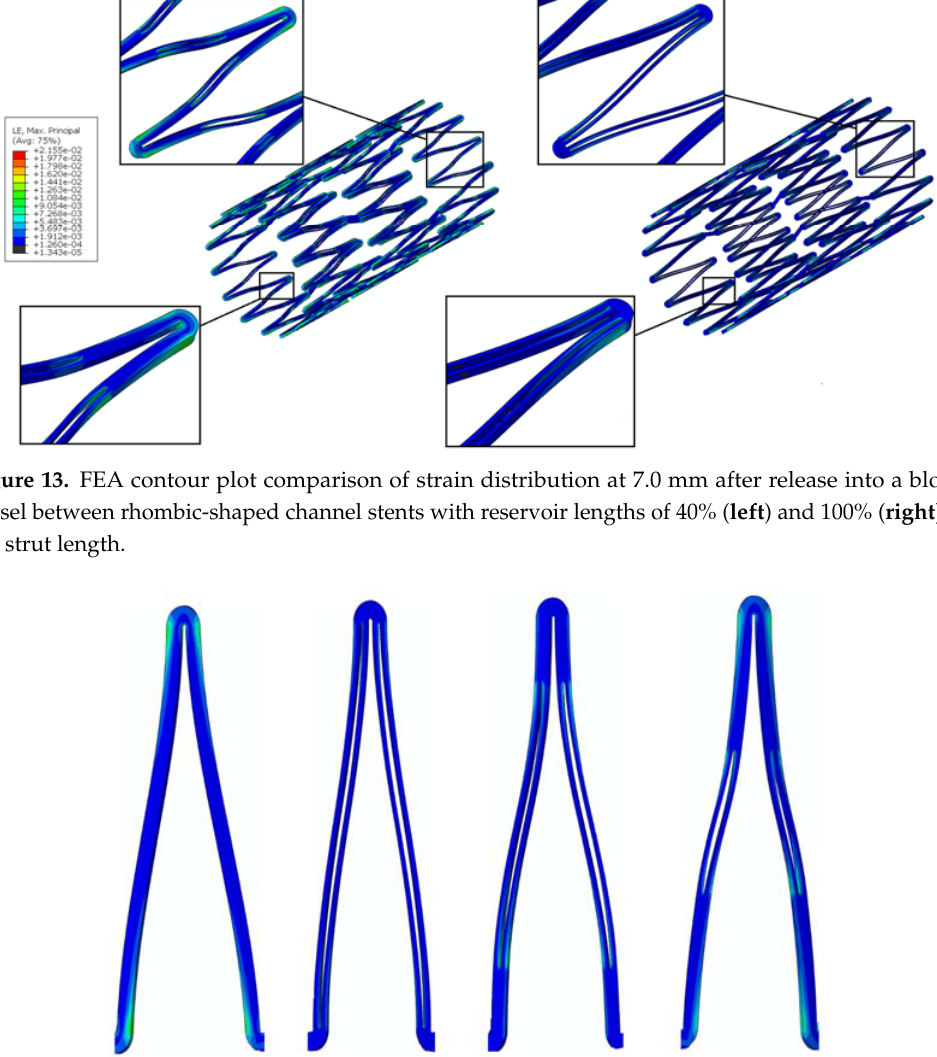
Figure 14. FEA comparison of stent deformed geometry at 7.0 mm after release into a blood vessel among the conventional DES stent and rhombic-shaped channel stents with reservoir lengths of 100%, 70%, and 40% of the strut length (from left to right).